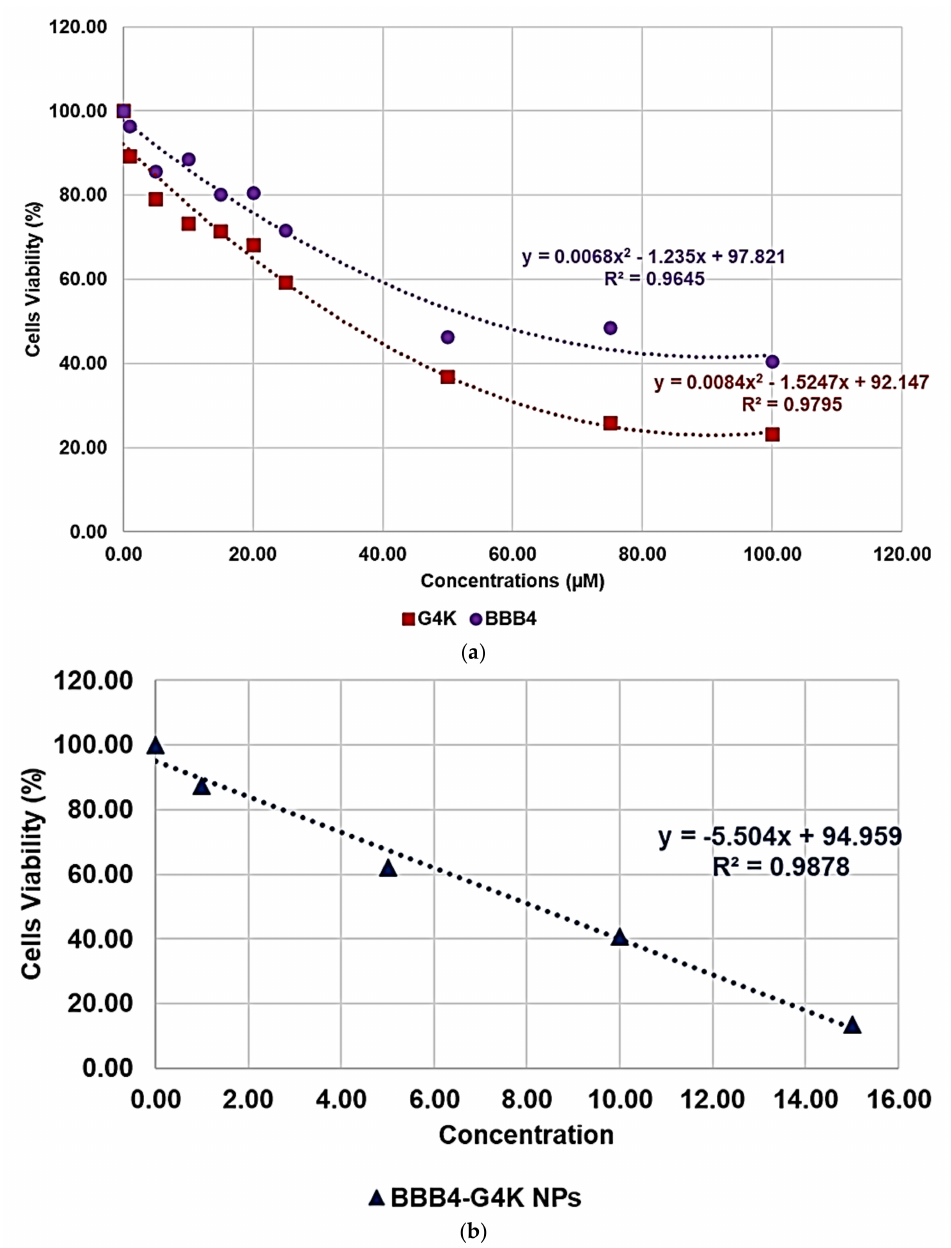
Figure 4. Regression models that better fit the dispersion graphs obtained, reporting in the graph the cell viability% vs. the concentration of samples at 24 h of exposure of BBB4 and G4K ( a ) and of BBB4-G4K NPs ( b